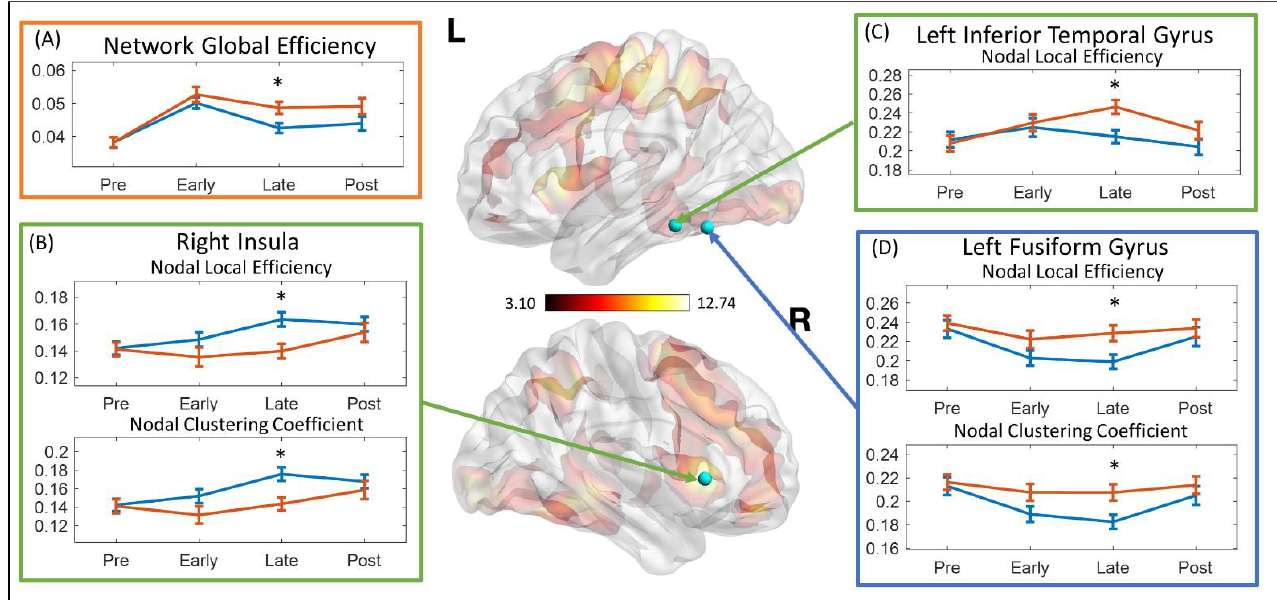
Figure 3. Standard deviation of network topological properties at different stages. The topological properties that showed significant group difference were marked with asterisk (*). ( A ) Standard deviation of the network global efficiency. ( B ) Standard deviation of the nodal local efficiency and the nodal clustering coefficient at right insula. ( C ) Standard deviation of the nodal local efficiency at left inferior temporal gyrus. ( D ) Standard deviation of the nodal local efficiency and the nodal clustering coefficient at left fusiform gyrus. L: left hemisphere; R: right hemisphere; Pre: pre-stimulation stage; Early: early stimulation stage; Late: late-stimulation stage; Post: post-stimulation stage.